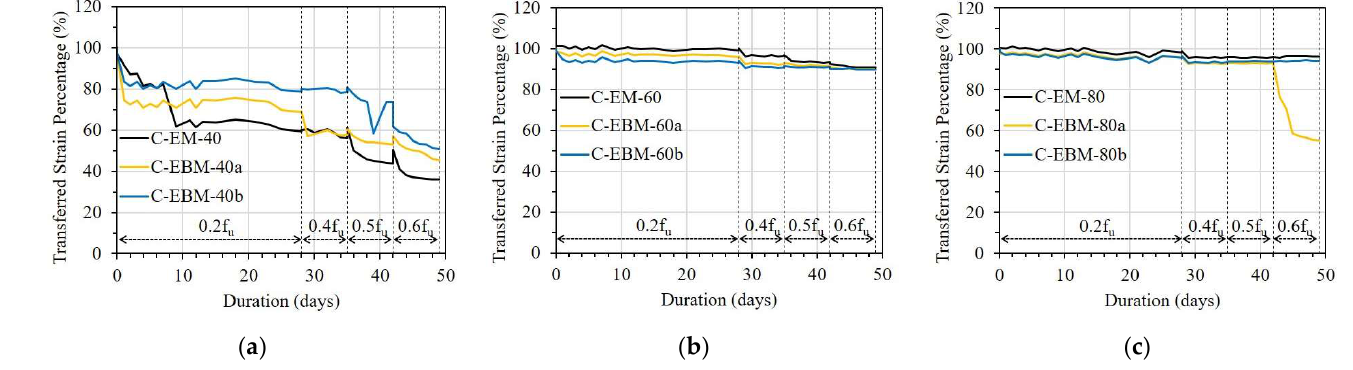
Figure 15. Short-term creep effect on strain transfer of the C specimen with different bonding methods: ( a ) L = 40 mm; ( b ) L = 60 mm; and ( c ) L = 80 mm.